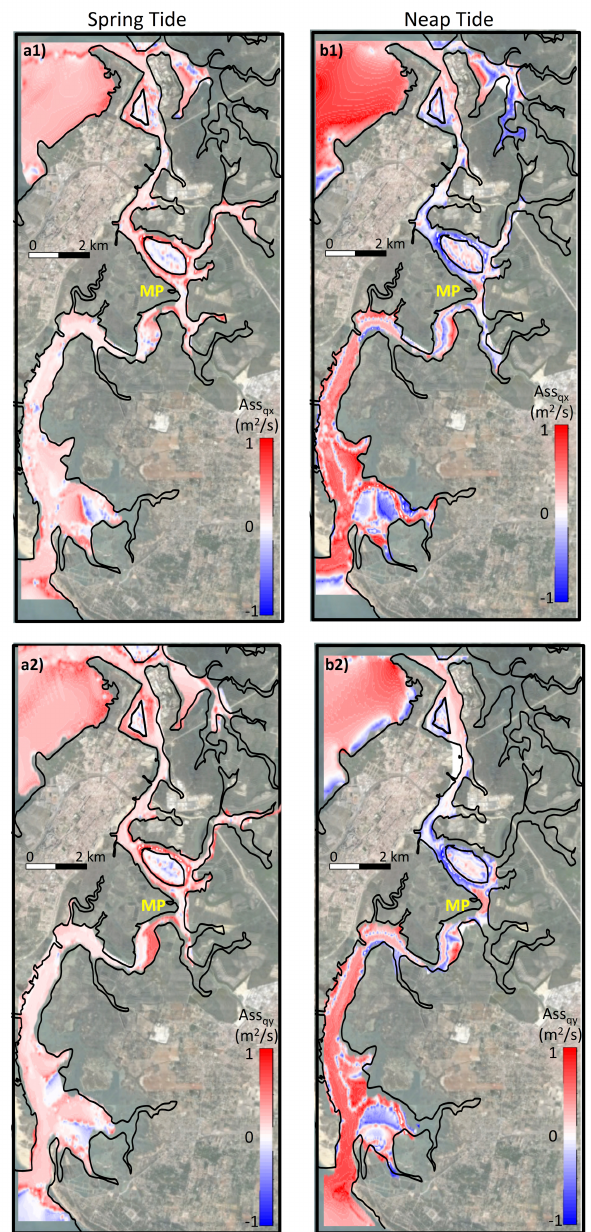
Figure 14. Spatial distribution of the asymmetry magnitude Ass qx (panels ( a1 , b1 )) and Ass qy (panels ( a2 , b2 )) along the creeks for spring ( a ) and neap ( b ) tides,